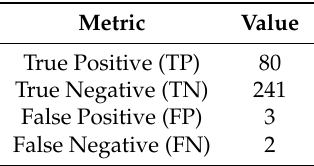
Table 3. Contingency table for the binary classification of the